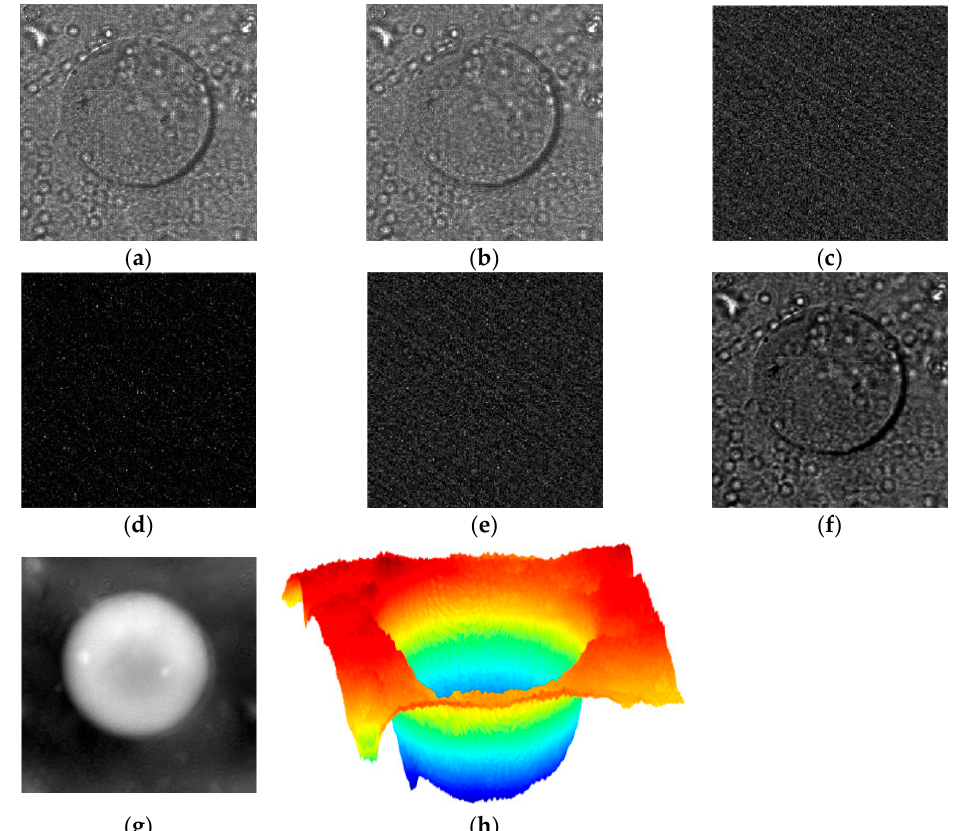
Figure 5. Results with a micro-lens used as sample. ( a ) and ( b ) Defocused intensities recorded on CCD camera, ( c ) one of the scrambled images of the defocus intensities, ( d ) ciphertext, ( e ) key, ( f ) decrypted defocused intensity, ( g ) retrieved phase map, and ( h ) surface plot of the phase map.